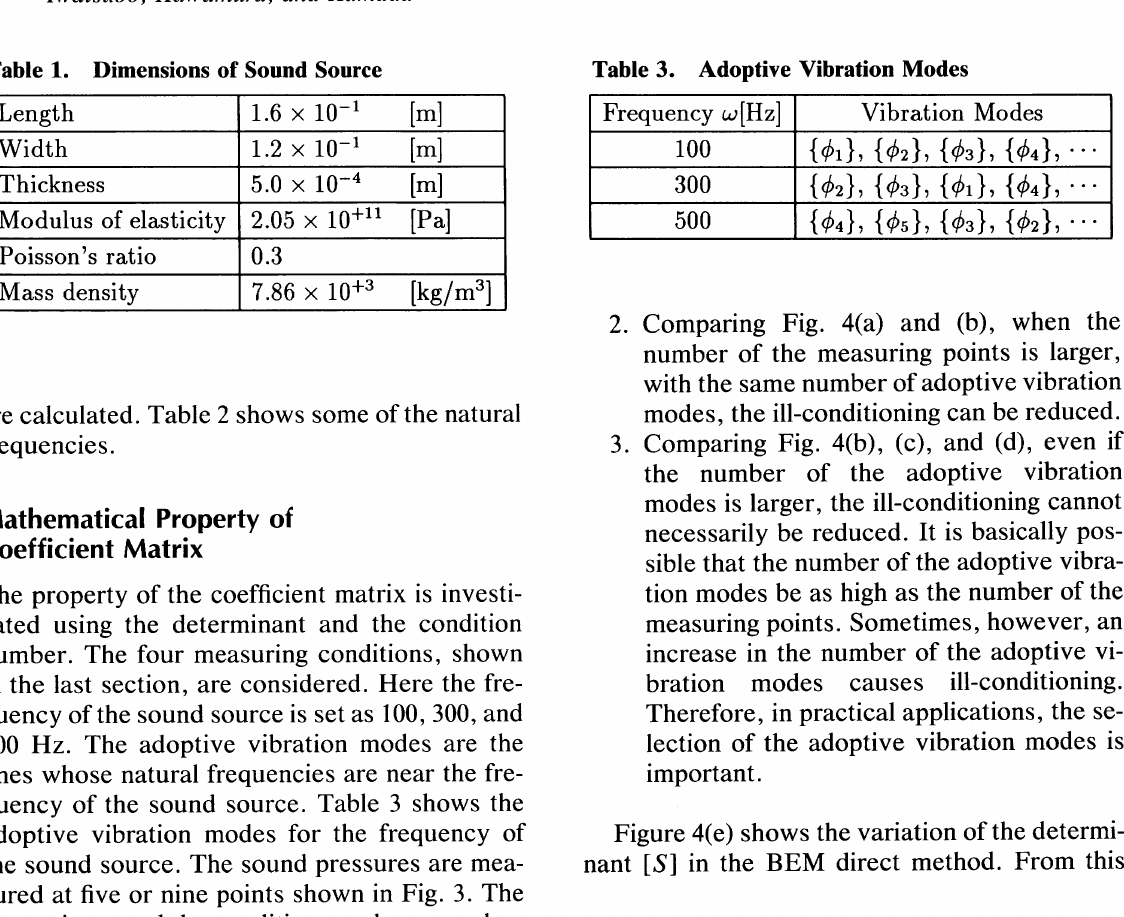
Table 1. Dimensions of Sound Source Table 3. Adoptive Vibration Modes